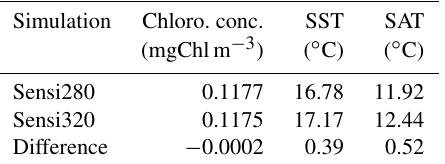
Table C1. Chlorophyll concentration (mgChlm − 3 ), sea surface temperature and atmospheric surface temperature ( ◦ C) for the sen- sitivity analysis of the climate. The difference represents the value of Sensi320 minus the value of